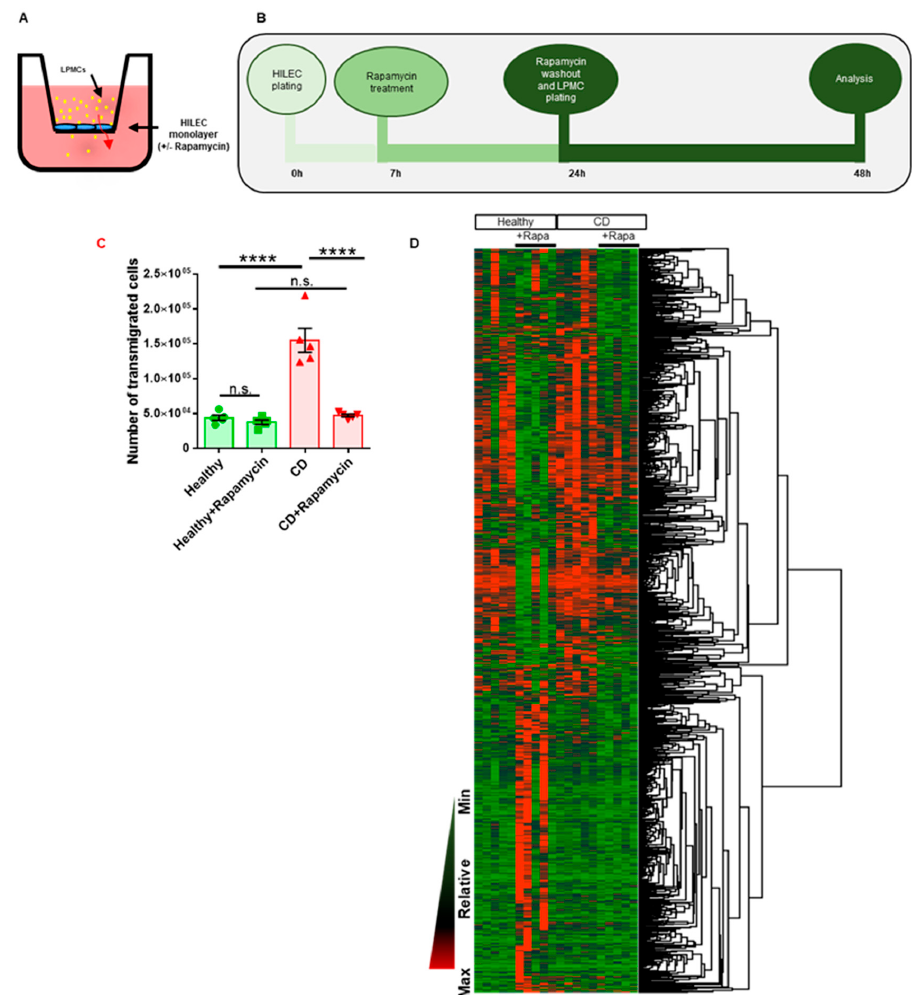
Figure 2. mTOR pathway oversees LPMC transmigration across CD HILECs. ( A ) Graphical representation of the transwell-based assay. ( B ) Schematic description of CD and healthy HILEC treatments with rapamycin during the transmigration assay. ( C ) Scatter plot with bars showing the number of transmigrated LPMCs at the indicated conditions. ( D ) Heatmap showing variations of gene expression in CD and healthy HILECs with or without rapamycin treatment. N = 5/group. Data are represented as mean ± s.e.m. **** p ≤ 0.0001, n.s. not significative.